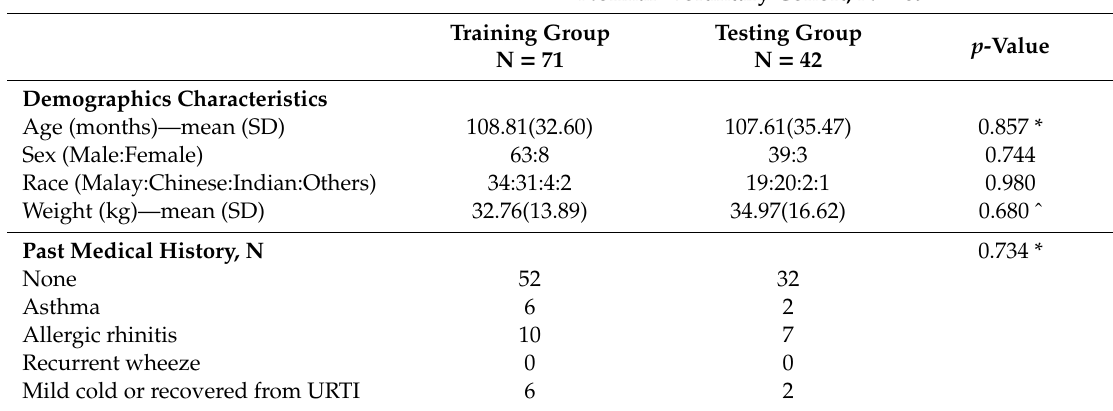
Table 3. Clinical characteristics of the study population in the normal–voluntary cohort. Population numbers (N) in the Past Medical History might include children with more than one medical condition, presented non-contemporaneously. * Independent T -test, ˆ Mann-Whitney U test, URTI (Upper Respiratory Tract Infection).